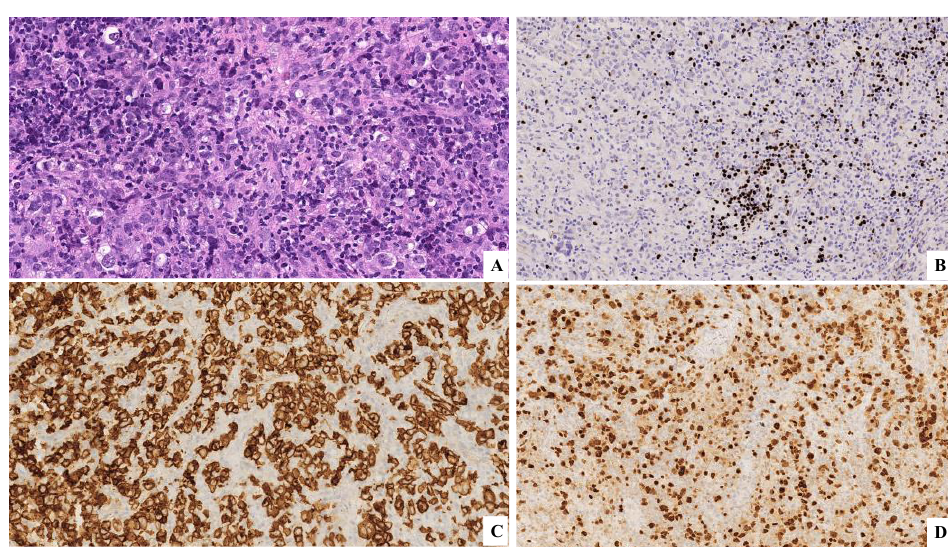
Figure 6. ( A ) H&E original magnification 20x that displays small T lymphocytes, eosinophils, histi- ocytes, classical Reed – Sternberg cells, and Hodgkin cells. ( B ) PAX5-. ( C ) CD30+. ( D ) MUM1+.